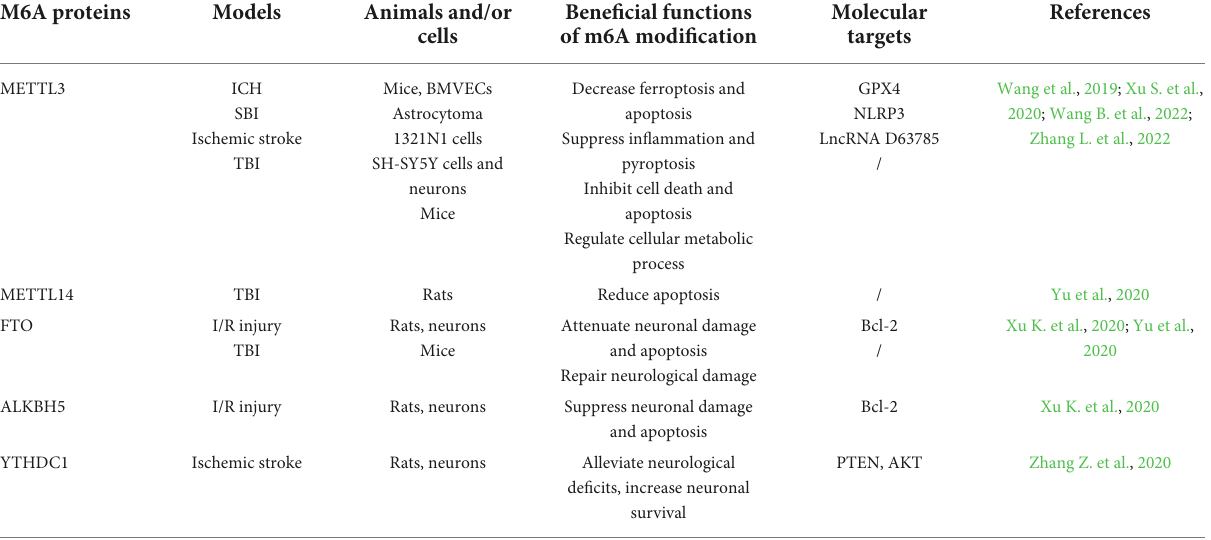
TABLE 2 The functions and molecular targets of m6A proteins in CNS